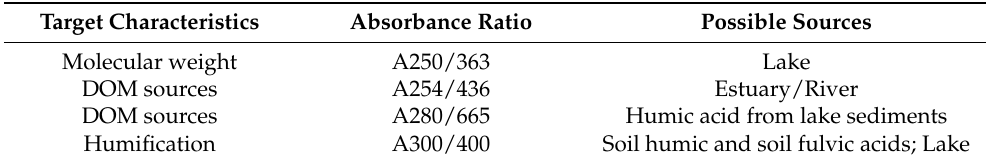
Table 4. Absorbance ratio used in interpreting DOM of SR and